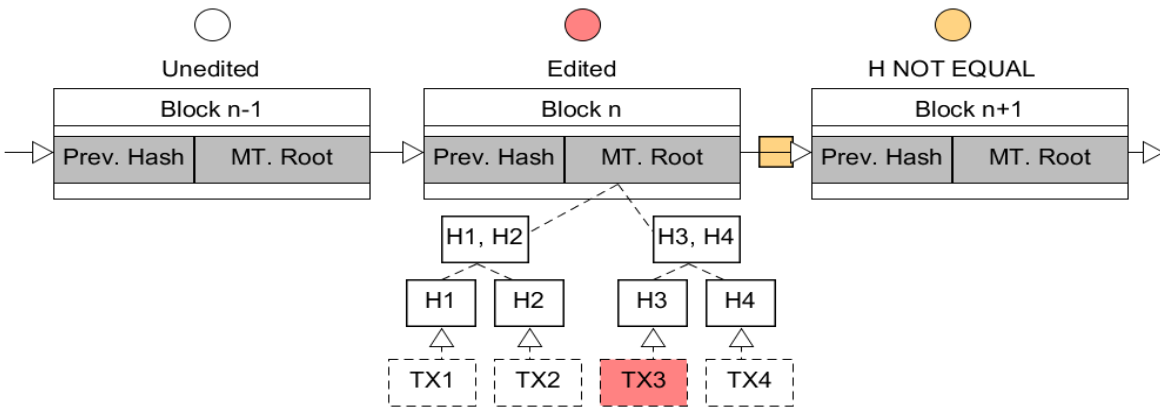
Figure 2. An instance of blockchain immutability.